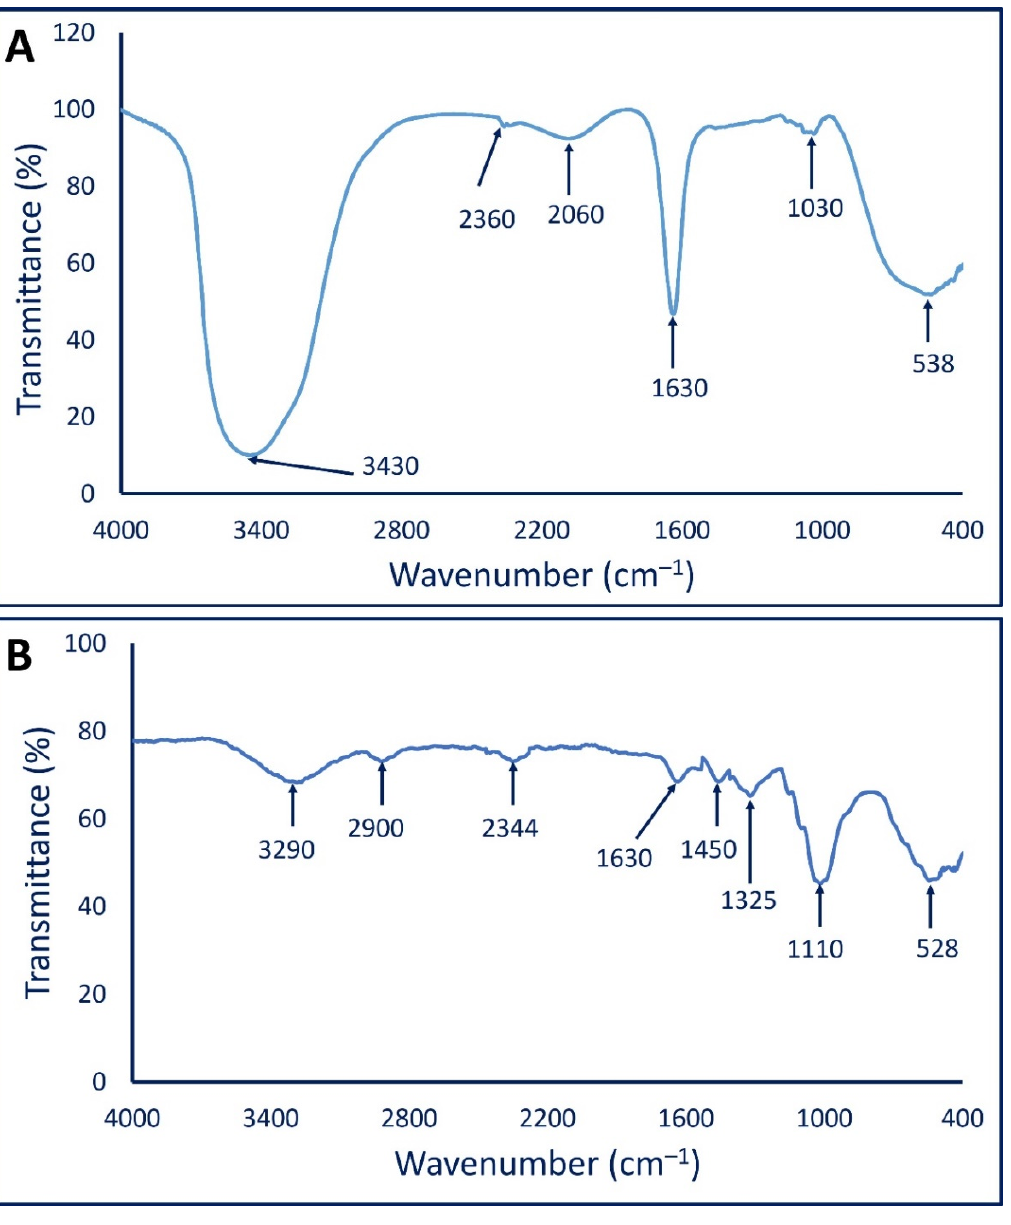
Figure 2. FT-IR spectra of fungal biomass filtrate ( A ) and Ag-NPs fabricated by Aspergillus niger strain F2 ( B ). F2 ( B